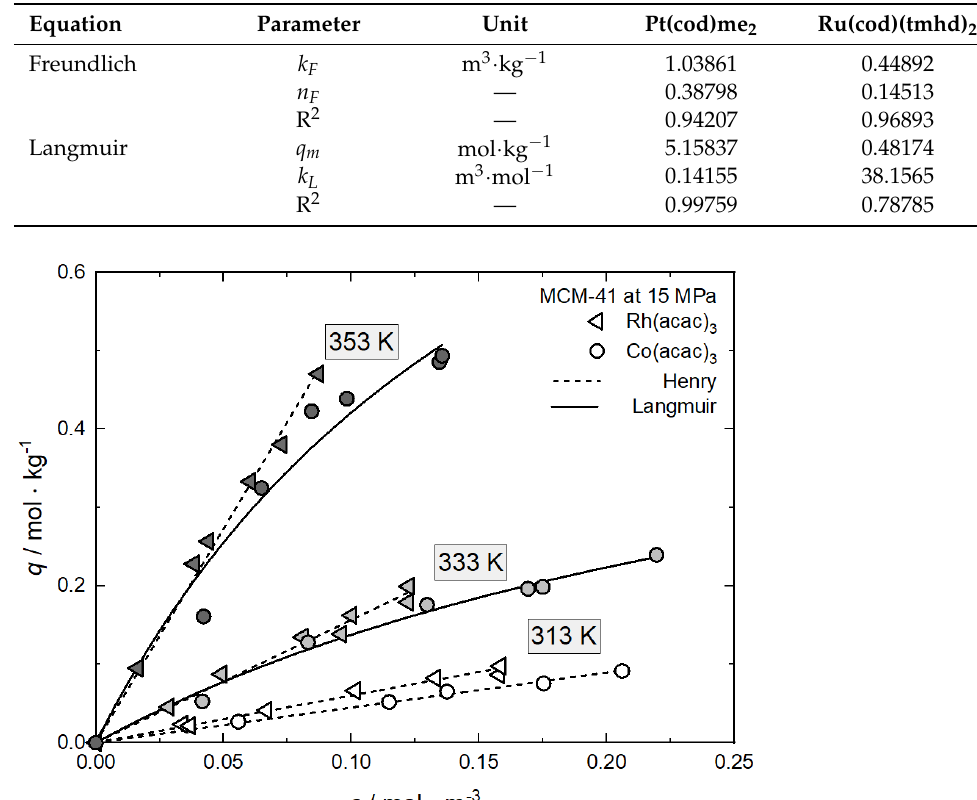
Table A19. Adsorption isotherm parameters of different precursors from scCO 2 solution on CA22 at